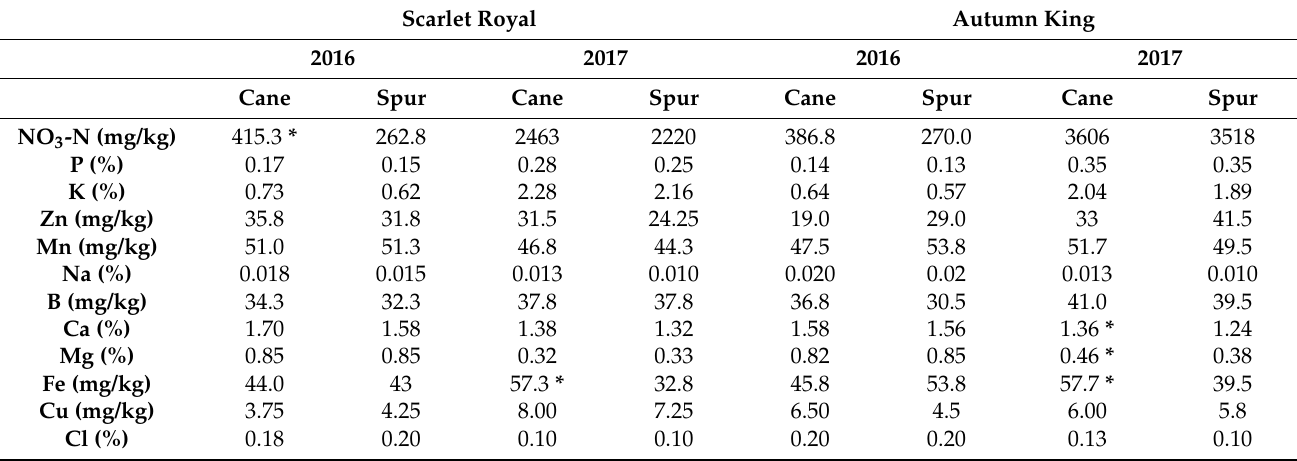
Table 3. Scarlet royal and Autumn king petiole’s nutrients content at veraison under cane and spur pruning systems. ANOVA statistical analysis was used to measure the differences among treatments at a 0.05 significance level. Error bars represent the standard deviation. Asterisk (*) indicates the significantly different